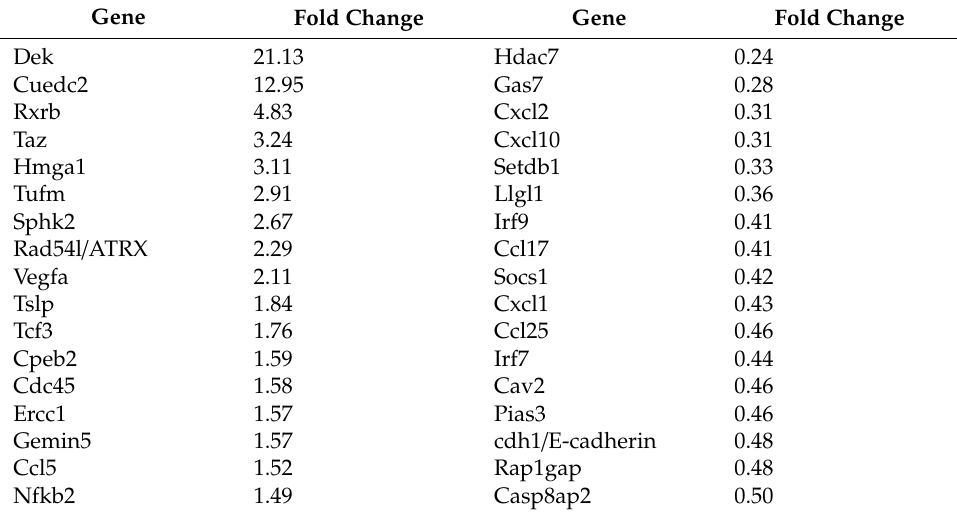
Table1. Selectedup-anddown-regulatedgenesinDekexpressingcellsenrichedforimmunomodulatory genes and previously identified Dek target